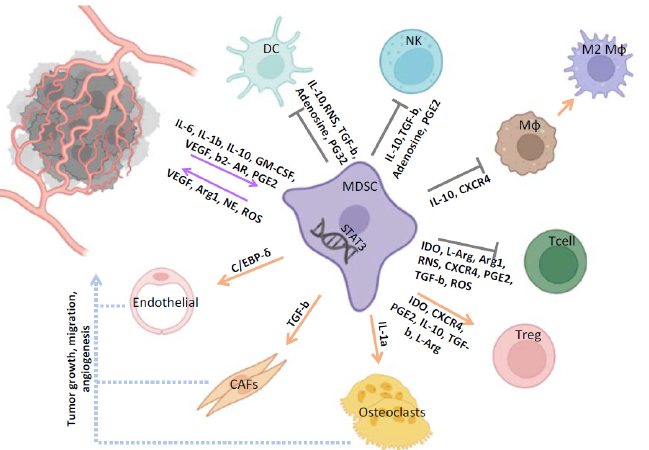
Figure 1. The role of MDSCs in the tumor-associated microenvironment of PCa. MDSCs exert their tumor promoting and immunosuppressive functions through induction of different signaling pathways and release of various factors. MDSCs suppress NK, M φ , DC, and the cytotoxic activity of T cells, and also induce Tregs and M2 immunosuppressive phenotypes. MDSCs also participate in tumor formation, metastasis, and migration through interaction with CAFs, endothelial cells, and osteoclasts. MDSC, myeloid-derived suppressor cell; DC, dendritic cell; NK, natural killer; M Φ , macrophages; T cell, T lymphocytes; Treg, T regulatory cell; CAF, cancer-associated fibroblast.